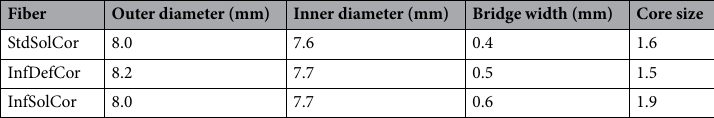
Table 2. Fiber dimensions.